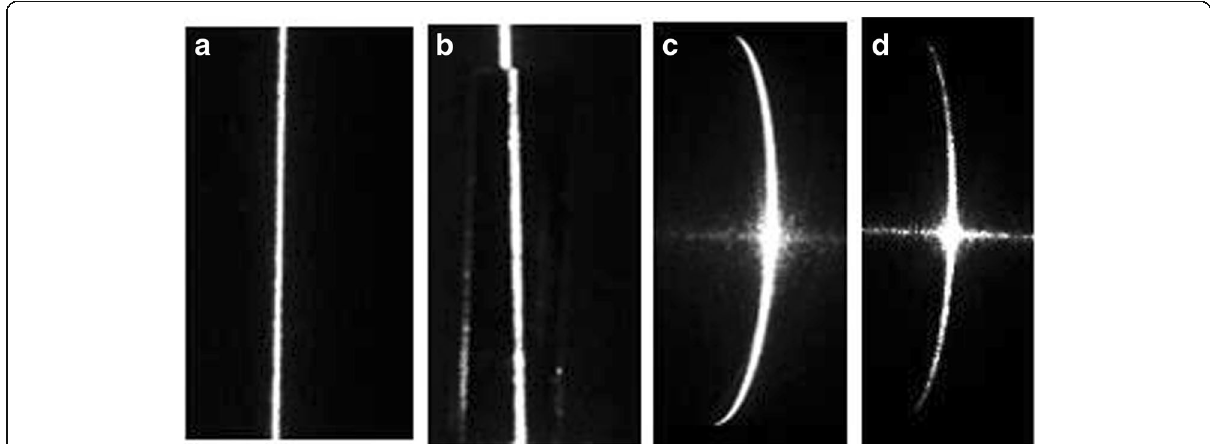
Fig. 2 Light strips images on different measured objects. a paper plane b metal plane c metal curved surface d specularly reflective metal